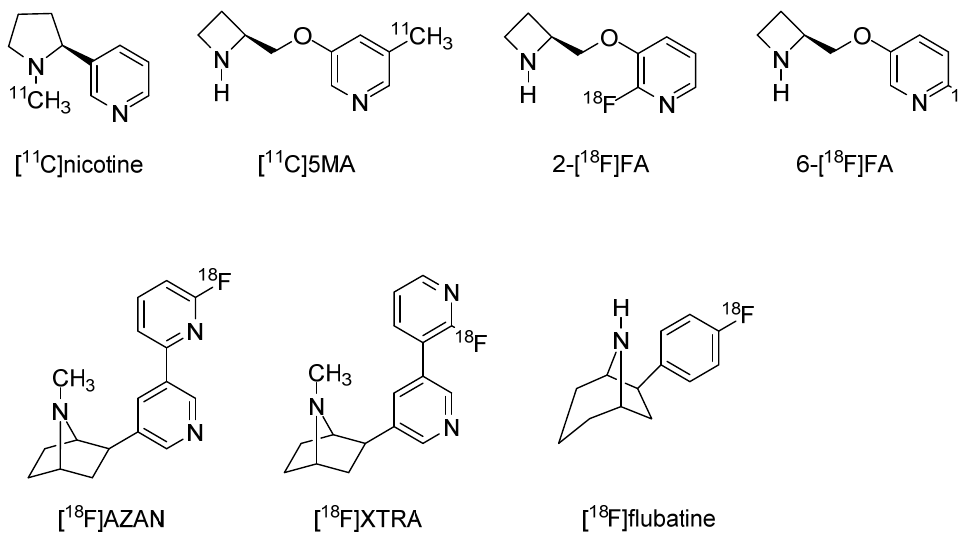
Figure 1. Representative α 4 β 2 nAChRs radioligands for PET.